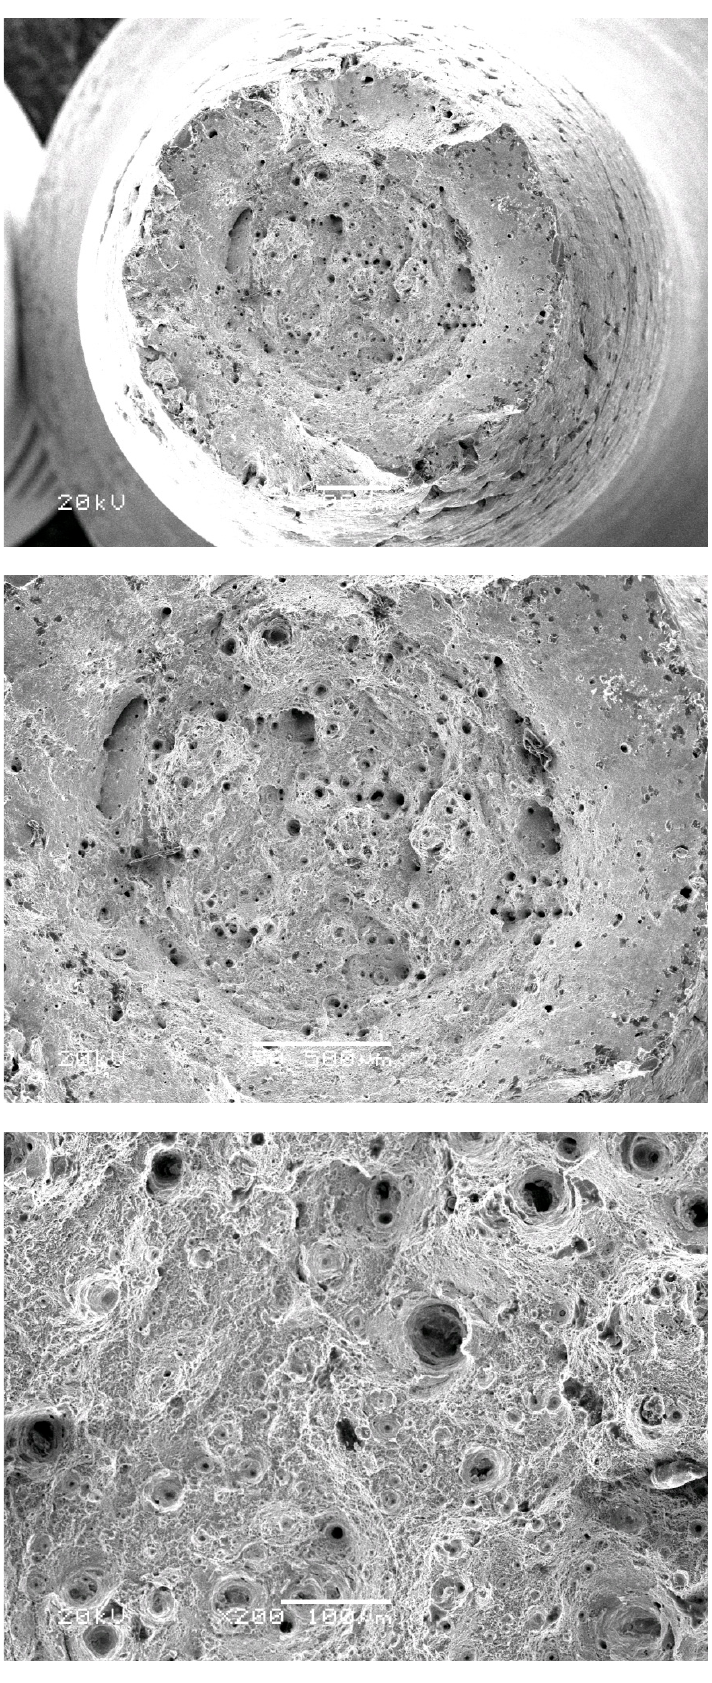
Figure 6. SEM micrographs (25×, 50× and 200×) of specimen 15.